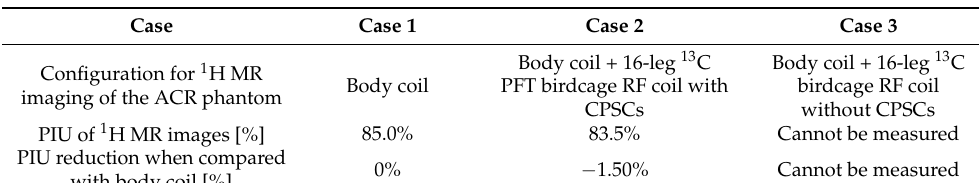
Table 3. 1 H MR experimental results for verifying the performance of the proposed CPSCs. The data are then compared with the FDTD simulation results shown in Table 2.